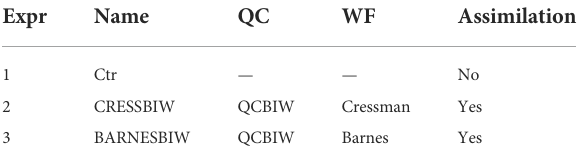
TABLE 1 Experimental design.